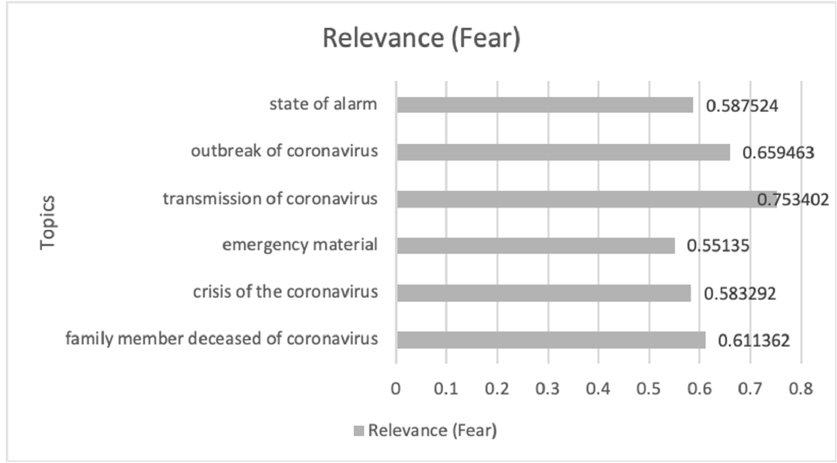
Figure 11. The themes related to COVID-19 and Anger emotion that have impacted most along with its impact